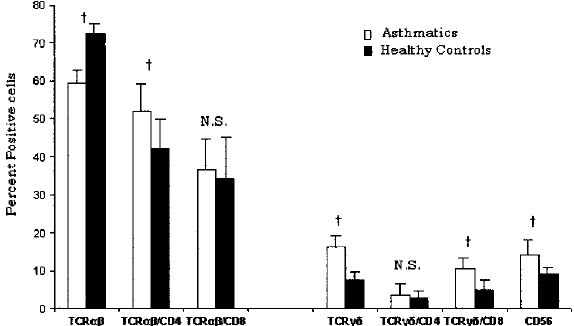
FIG. 1. Expression of TCR ab , TCR gd , CD4, CD8, and CD56, analysed by immunofluorescence staining and flow cyto- metry. Results are expressed as percentage positive cells, shown as mean ± standard error of the mean for induced sputum from 10 asthmatic patients with acute exacerbation of asthma and from 10 healthy controls.† Significantly different between asthmatic patients and healthy controls ( p < 0.001); N.S., not significantly